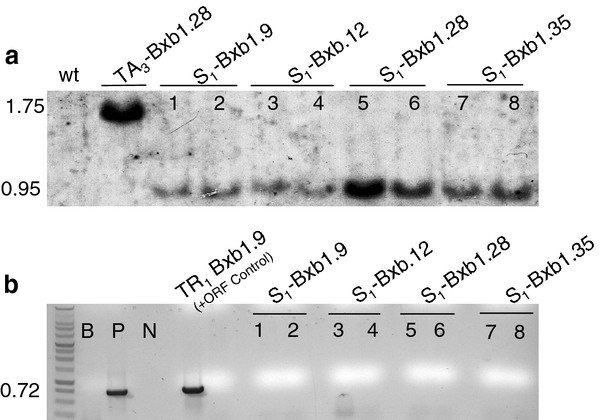
S1 plants examined by Southern blot analysis and whole plant genomic PCR. (a) Genomic DNA cleaved with EcoRV hybridized with a 32P-labeled GUS1350 probe (Figure 1). (b) Genomic DNA PCR amplified with with primers e and f. Plant lines (lanes 1, 2) S1-Bxb1.9; (lanes 3, 4) S1-Bxb1.12; (lane 5, 6) S1-Bxb1.28; (lane 7, 8) S1-Bxb1.35. Control lanes are wt (wild type Arabidopsis DNA) and TA3-Bxb1.9, (target lines).